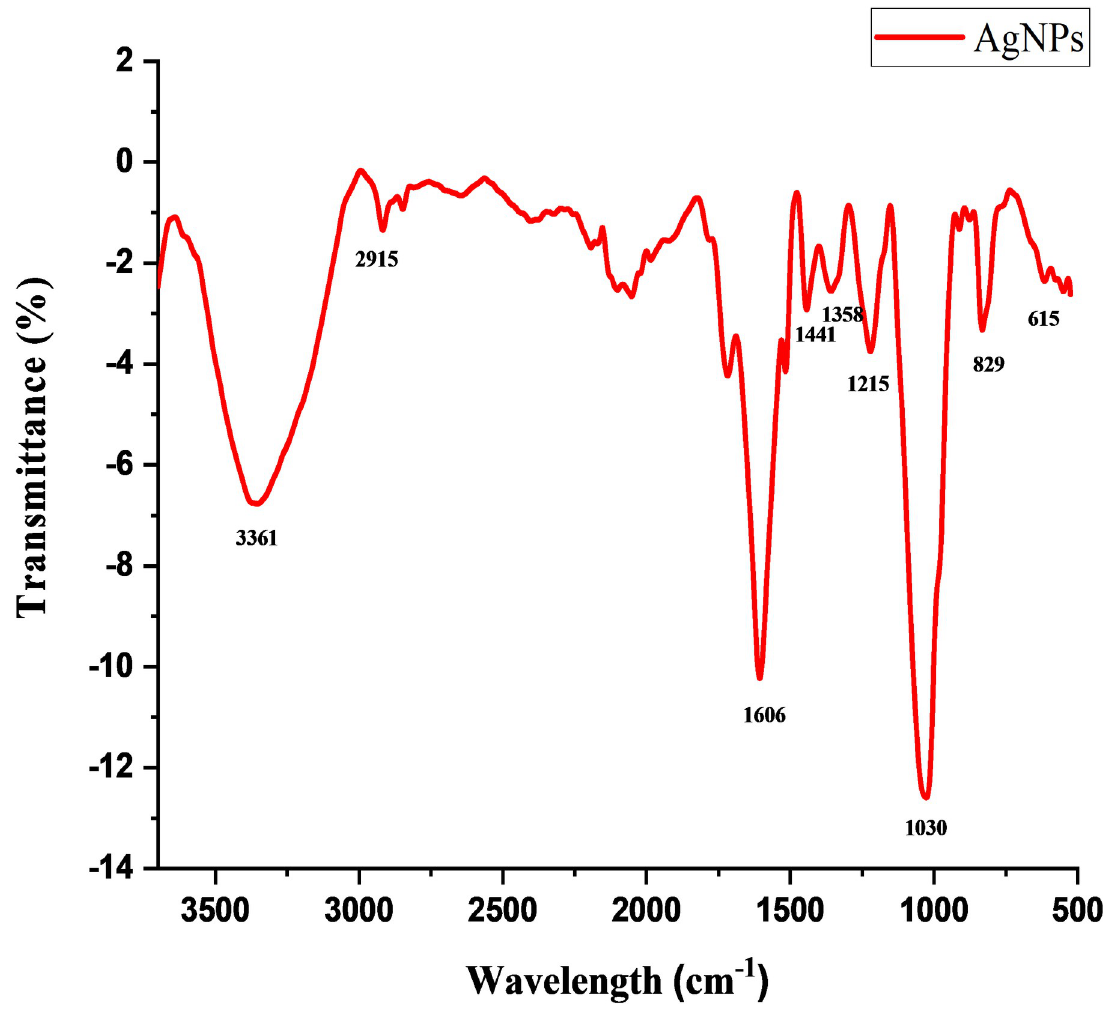
Fig 3. FTIR analysis of green synthesized